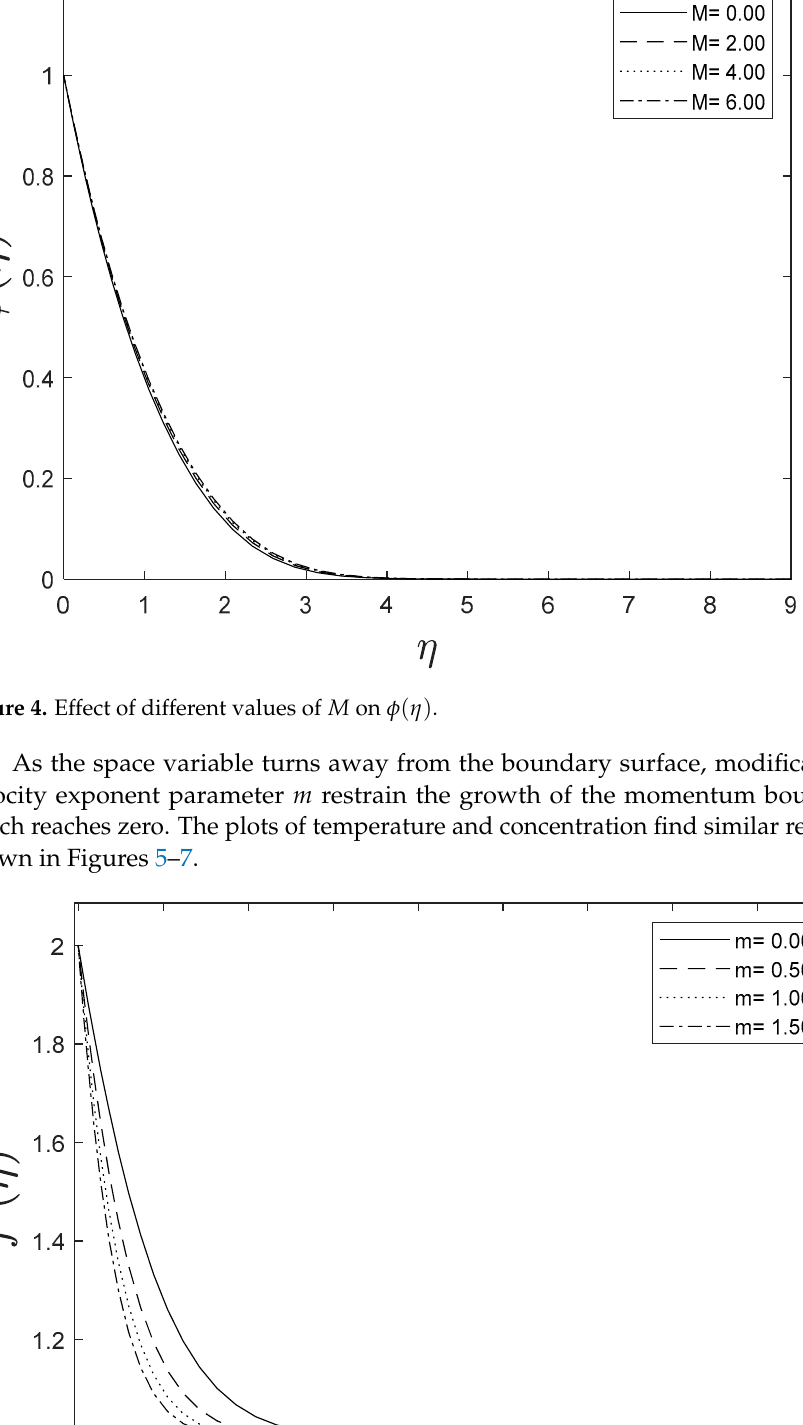
Figure 3. Effect of different values of M on